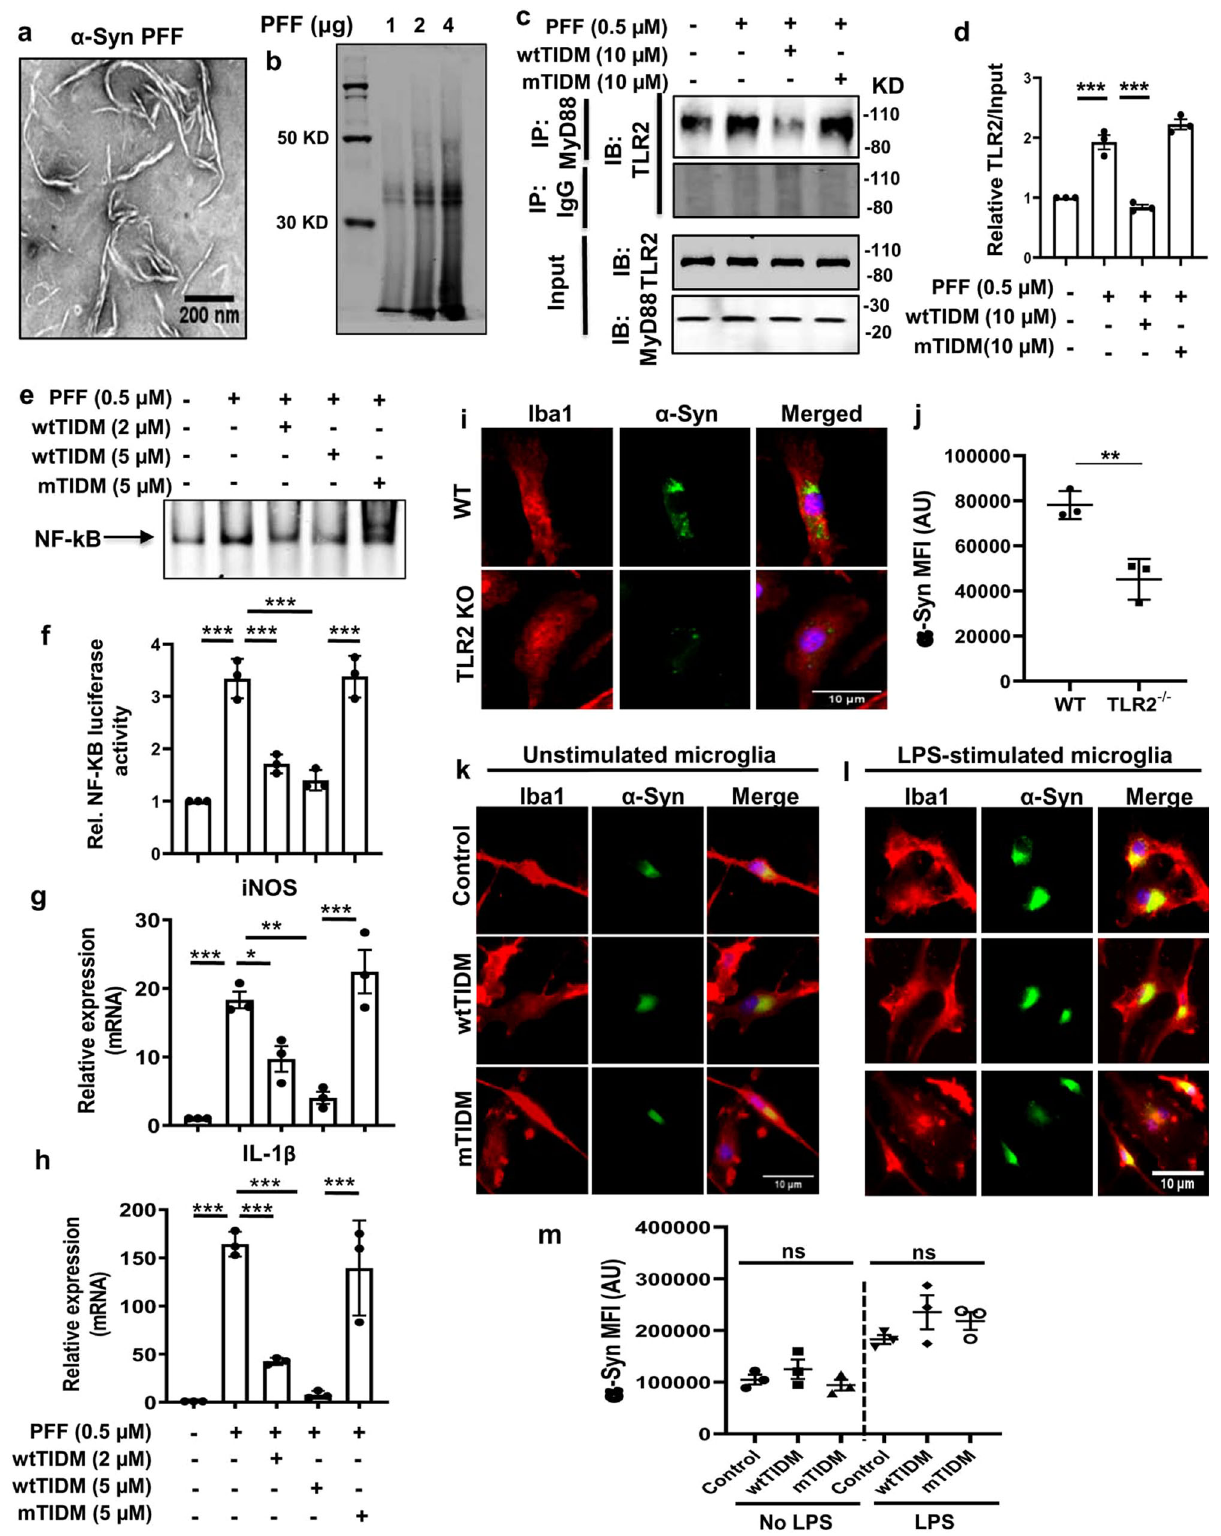
astrocytes (Supplementary Fig. S3g, h) in the SN of A53T mice expressed a signi fi cantly higher level of TLR2 compared to the respective cell types in the non-transgenic (nTg) animals. Prior to conducting experiments in A53T animals, we evaluated the bioavailability of TIDM peptides in the brain of TIDM-treated B6C3 mice by using Alexa-680-labeled TIDM peptides.